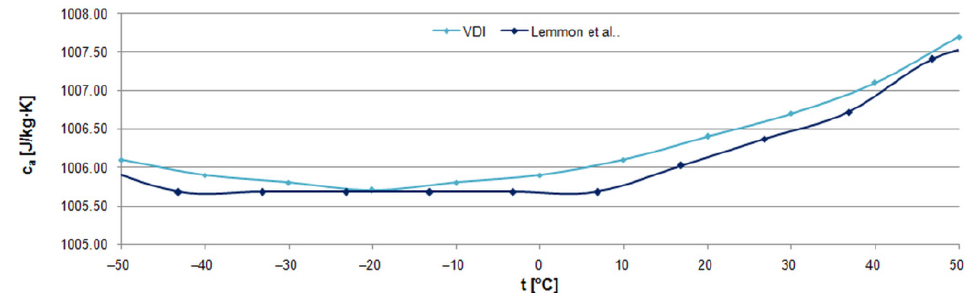
Figure 6. Specific heat of dry air as a function of temperature.